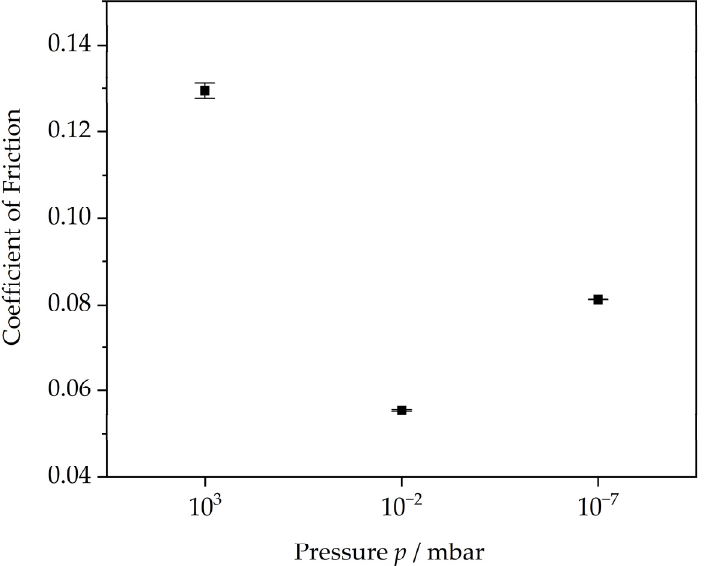
Figure 3. Comparison of steady-state friction coefficient of the brass/ta-C system at different pres- sures (for 12 m sliding distance). (for 12 m sliding